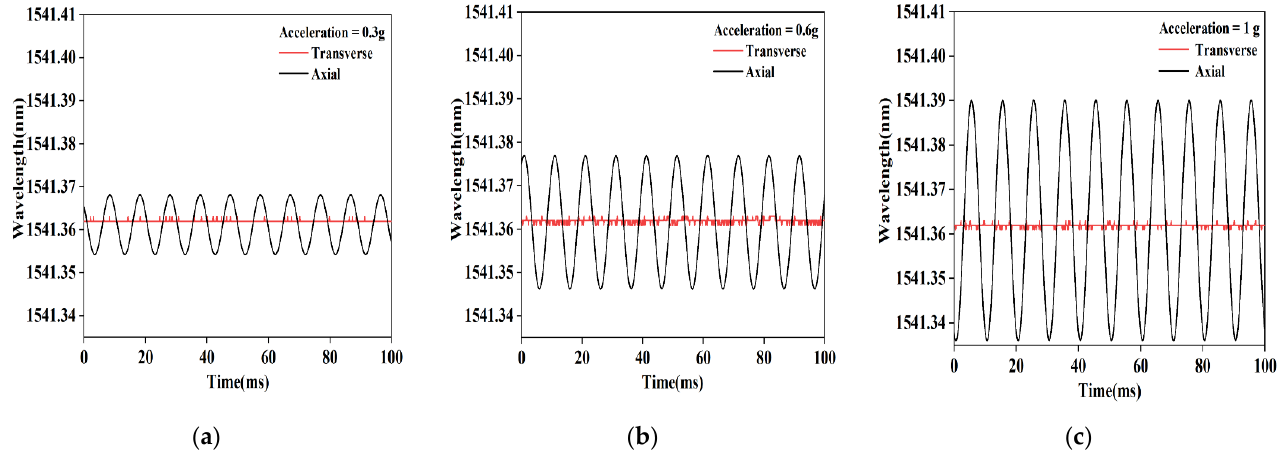
Figure 7. Comparison of axial and transverse responses of accelerometer 4 under a sinusoidal excitation signal with a vibration frequency of 100 Hz. ( a ) The vibration acceleration is 0.3 g. ( b ) The vibration acceleration is 0.6 g. ( c ) The vibration acceleration is 1